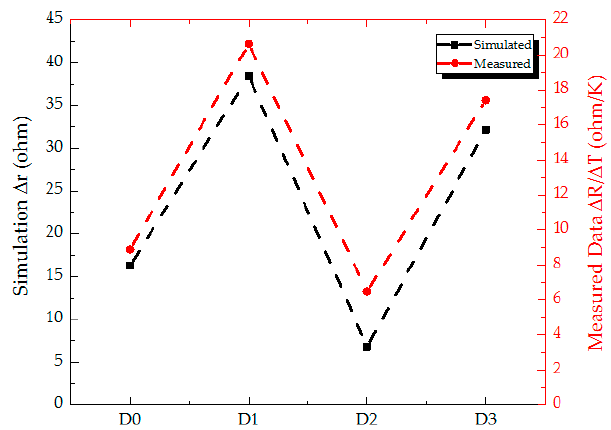
Figure 7. The Δ R/ Δ T and Δ r are measured and simulated, respectively. Figure 7. The ∆ R/ ∆ T and ∆ r are measured and simulated,